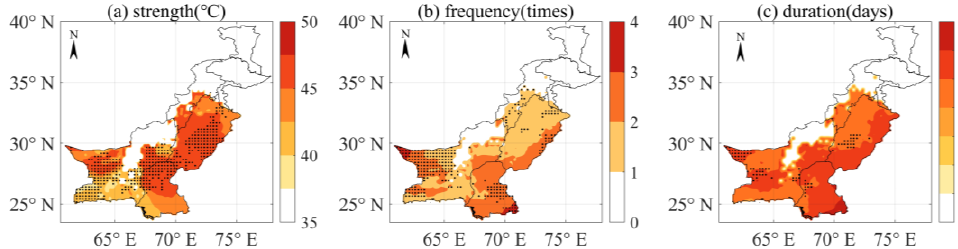
Figure 6. Time variation of extreme high-temperature events over the CPEC during 1961 – 2015: ( a ) strength; ( b ) frequency; ( c ) intensity. (Black dots represent where observer trends are significant ( p < 0.05)).